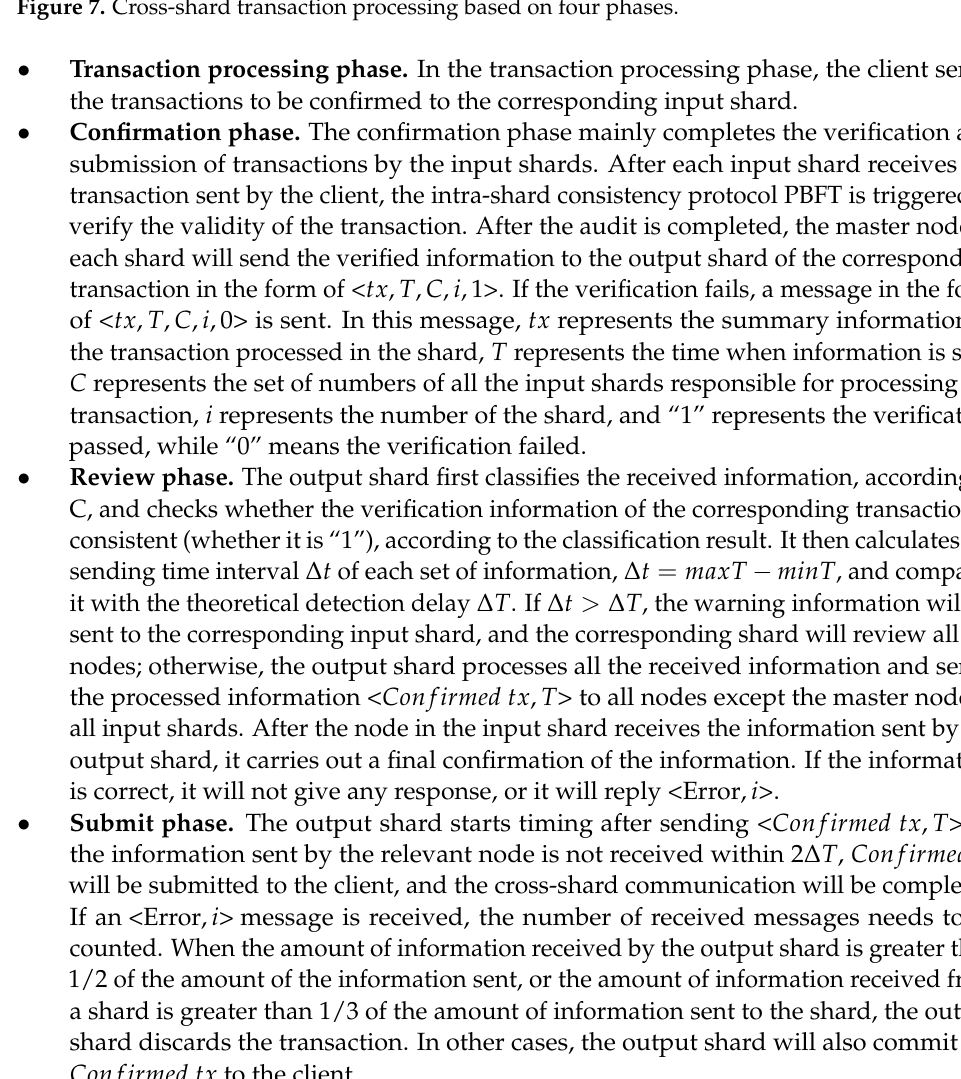
Figure 7. Cross-shard transaction processing based on four phases.